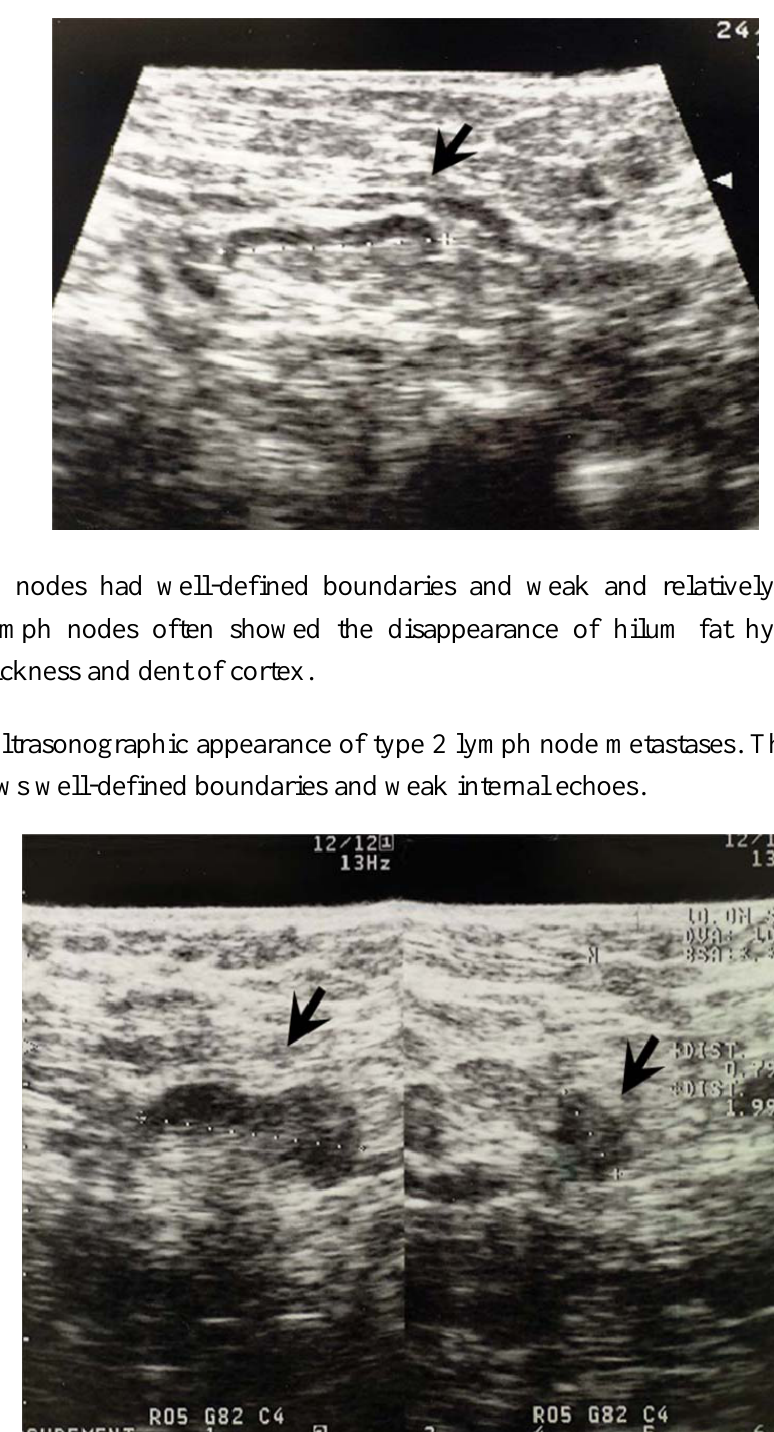
Figure 4. Ultrasonographic appearance of a normal lymph node (type 1). This lymph node (arrow) shows thin C-shaped low echoic cortex and regular cortex.